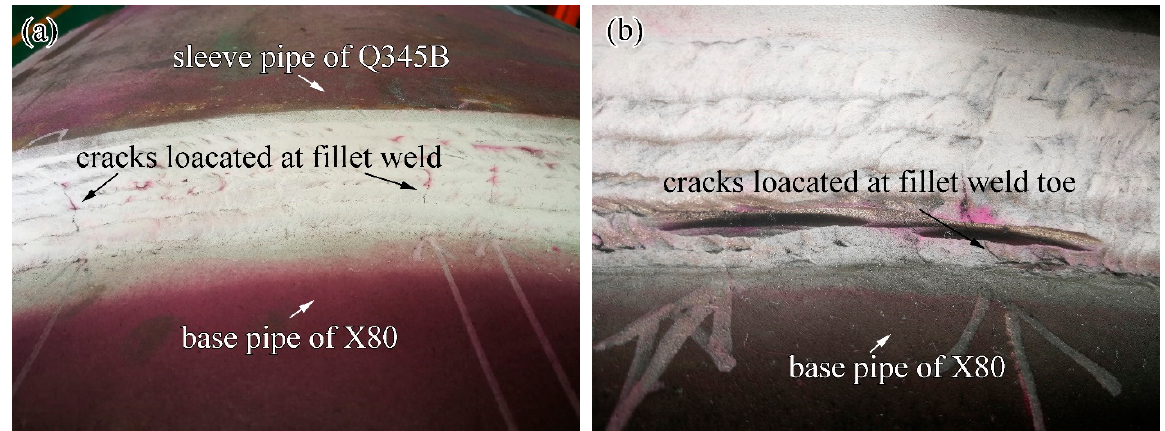
Figure 15. Fillet weld cracks in the weld zone: ( a ) cracks found on the outer surface, ( b ) cracks at the weld toe.